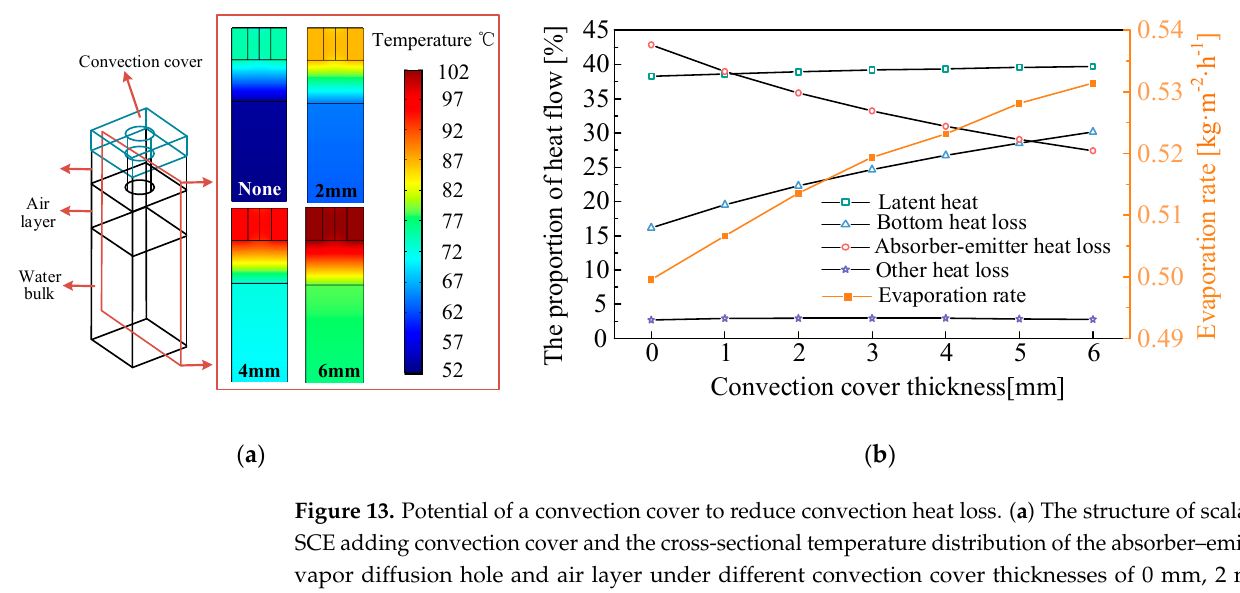
Figure 13. Potential of a convection cover to reduce convection heat loss. ( a ) The structure of scalable SCE adding convection cover and the cross-sectional temperature distribution of the absorber–emitter, vapor diffusion hole and air layer under different convection cover thicknesses of 0 mm, 2 mm, 4 mm and 6 mm. ( b ) The energy flow distribution and evaporation rate under different convection cover thicknesses.